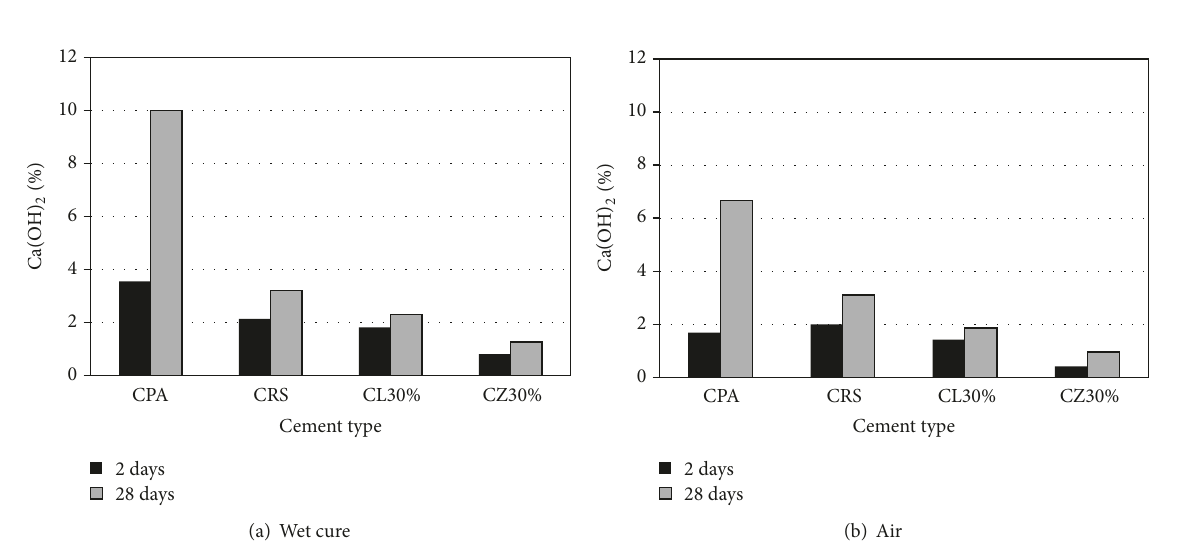
the CPA and 5.04%, 4.6%, and 3.07% for the CRS, CL30%, and CZ30%, respectively. Thus, for air-cured cement it is